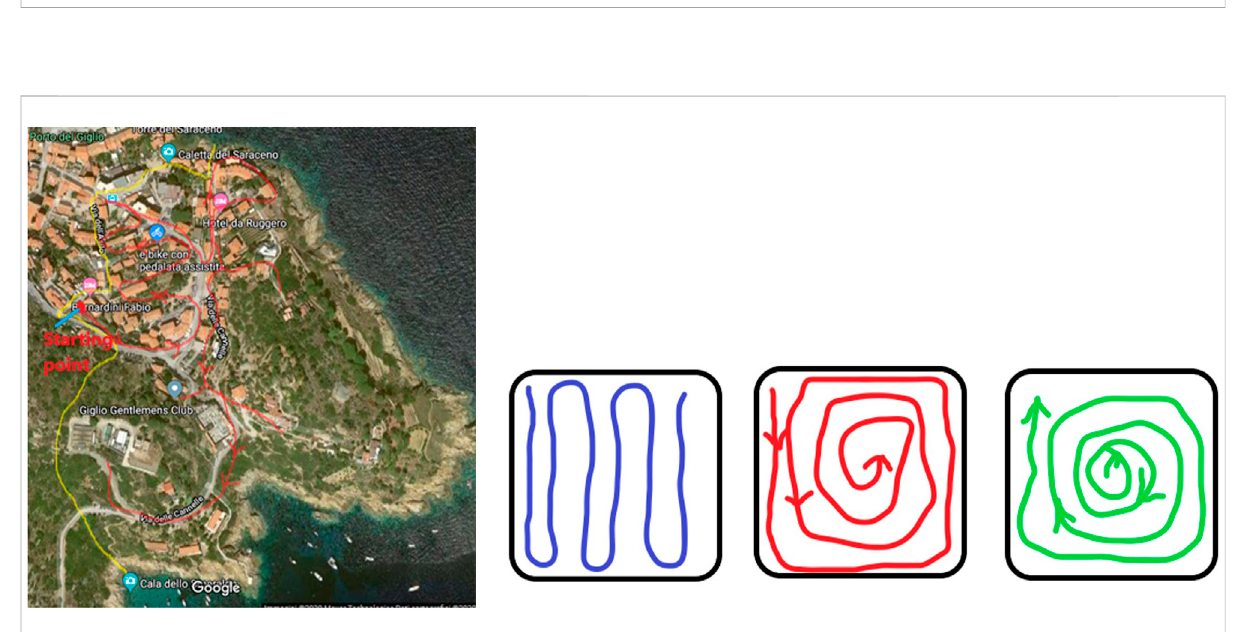
FIGURE 4 Example of a path for a stratum of the Giglio Island and examples of different paths that could be chosen for the same